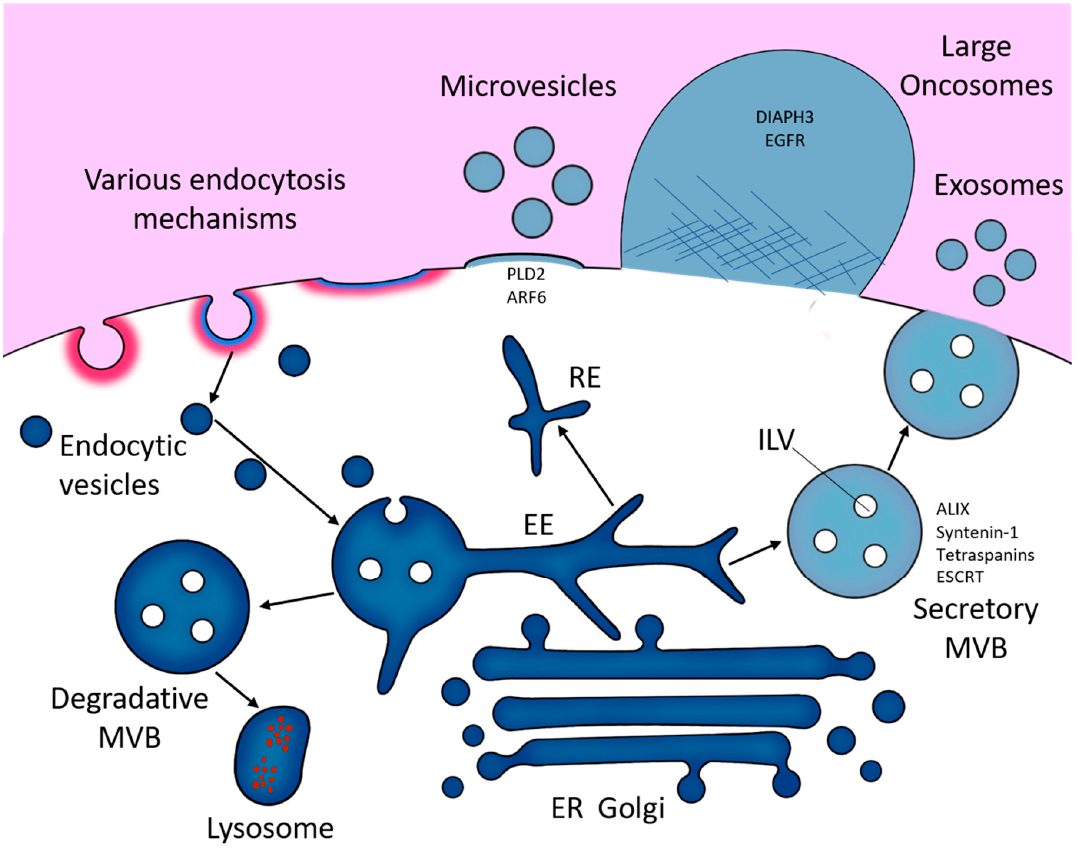
Figure 1. A diagram of the possible routes of formation of extracellular vesicles (EVs), via the endosomal pathway (exosomes), directly from membrane shedding (microvesicles) and via large-scale, non-apoptotic blebbing (large oncosomes). EE, early endosome; ER, endoplasmic reticulum; RE, recycling